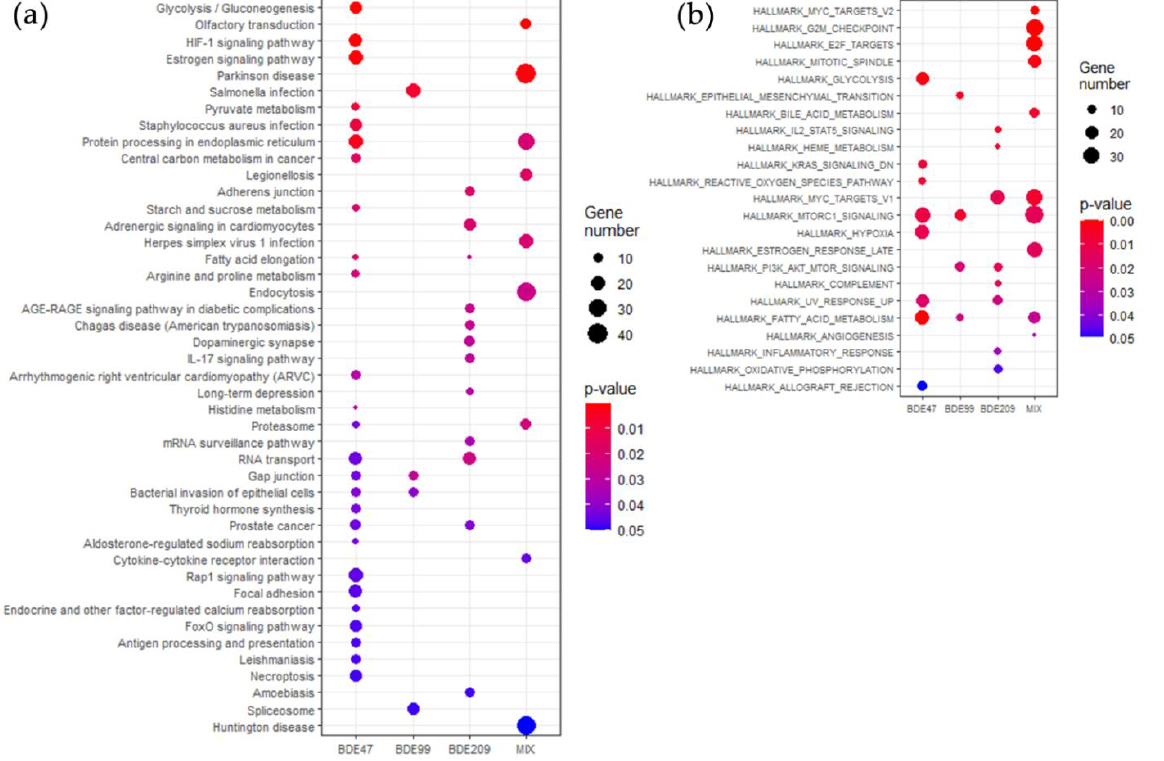
Figure 2. Dot plots of significantly enriched ( a ) KEGG pathways and ( b ) GSEA hallmark gene sets in HepG2 cells treated for 72 h with BDE-47, BDE-99, BDE-209, or MIX at 1 nM. The size of the dots is proportional to the number of featured entities and the color varies according to the p -value.